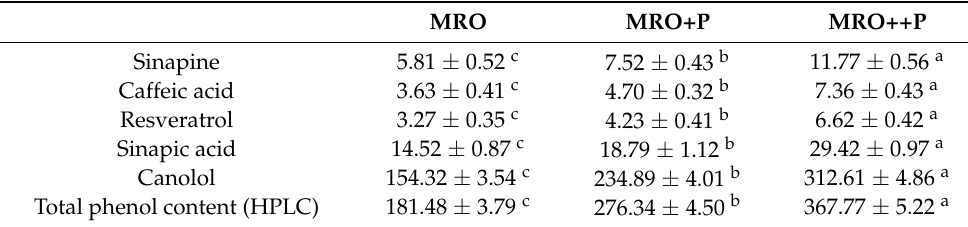
Table 1. The phenolic extracts composition (mg/kg) of the three initial oil